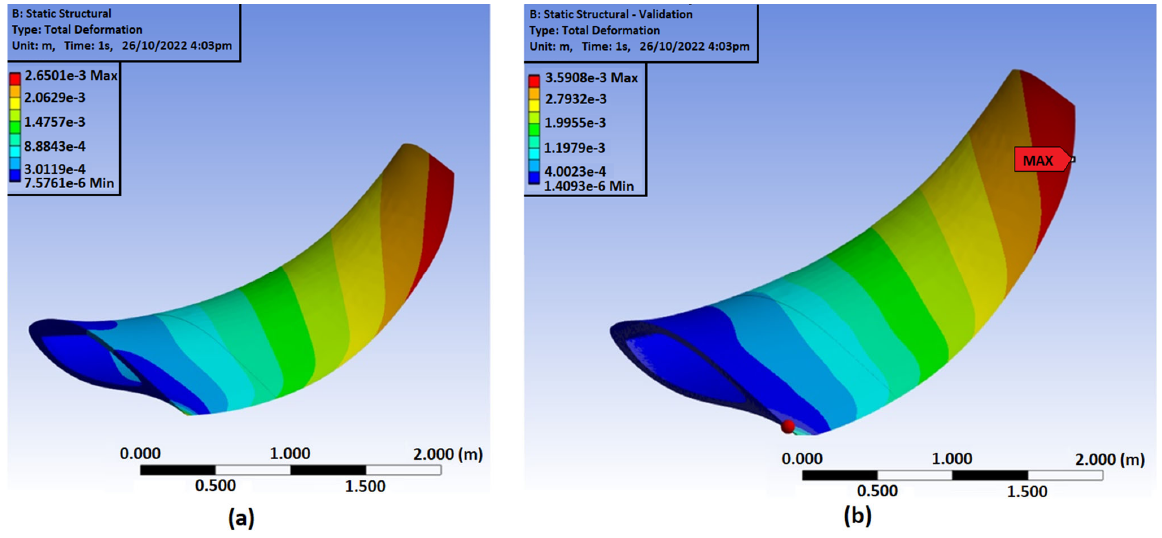
Figure 13. Comparative deformation color map. ( a ) Before TO, ( b ) after TO.